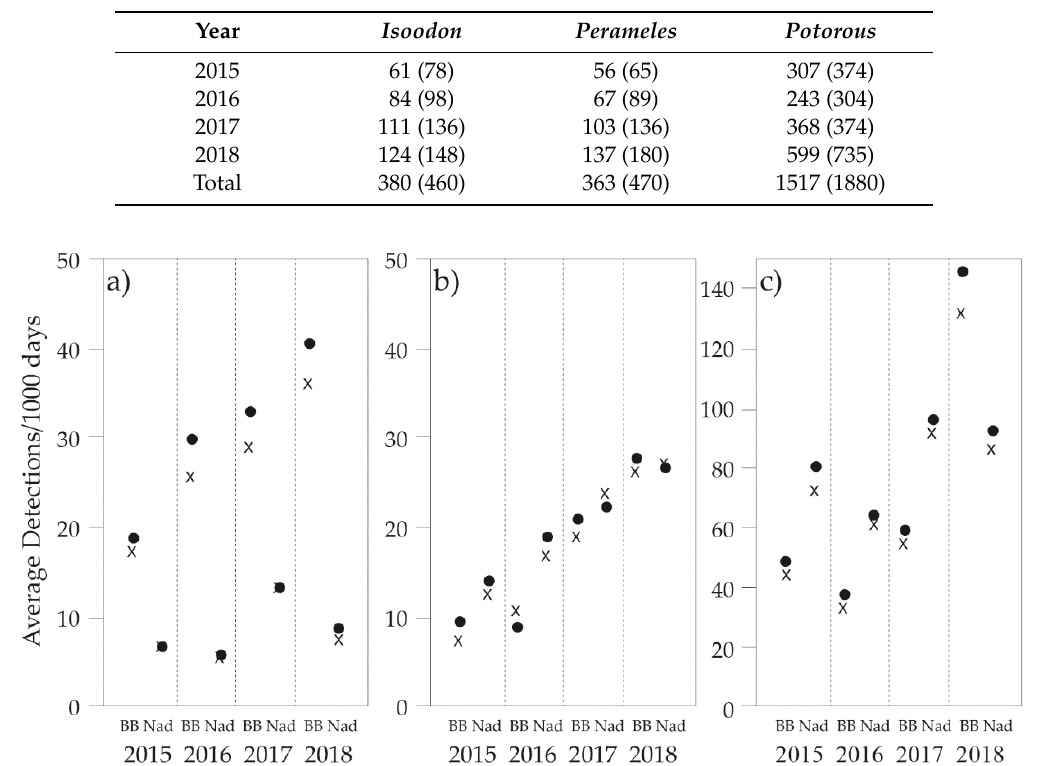
Table 3. Detection frequency of Isoodon , Perameles and Potorous during 2015–2018 for a 30-day (and 40-day) survey.